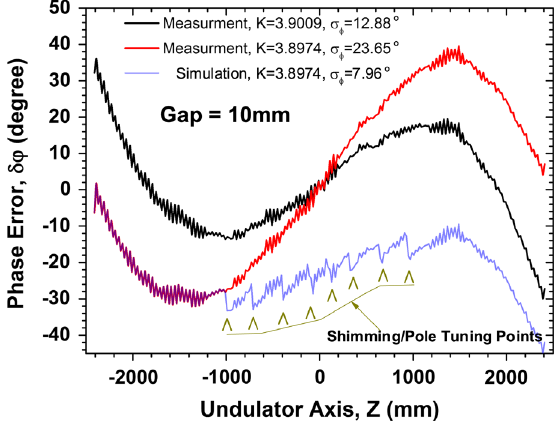
gap.FIG. 11. Phase error δ φ at 10 mm gap. Black: K ¼ 3 . 9009 , resulting in a minimum rms phase jitter of 12.88°. Red curve: K ¼ 3 . 8974 . Phase error at the start and end are approximately the same. Blue: Expected phase error with K ¼ 3 . 8974 after shimming. The expected rms error is